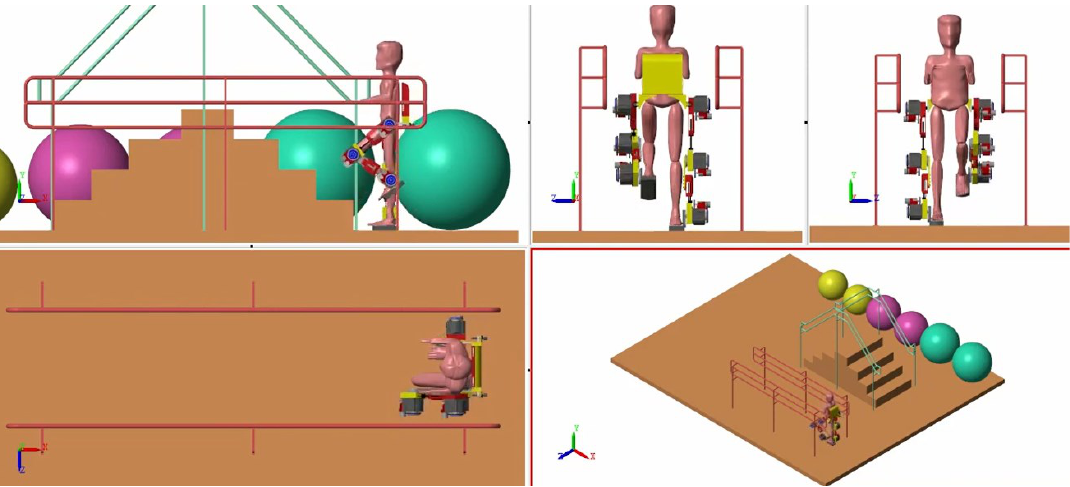
Figure 11. Virtual scenario for walking